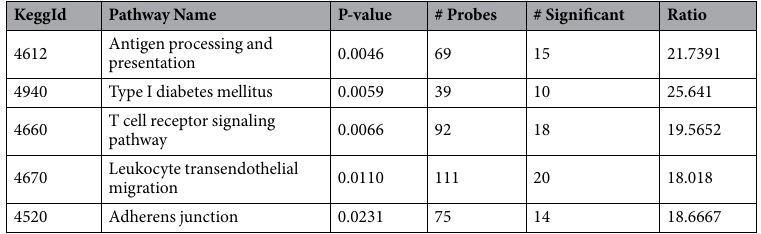
Table 1. List of significantly enriched KEGG pathways for the genes less varying in time with respect to twin couples ( Δ i < 1.5). KEGG